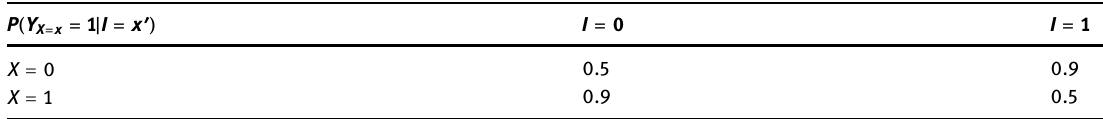
Table 5: Intent - speci fi c recovery rates for the confounded MediBot Example